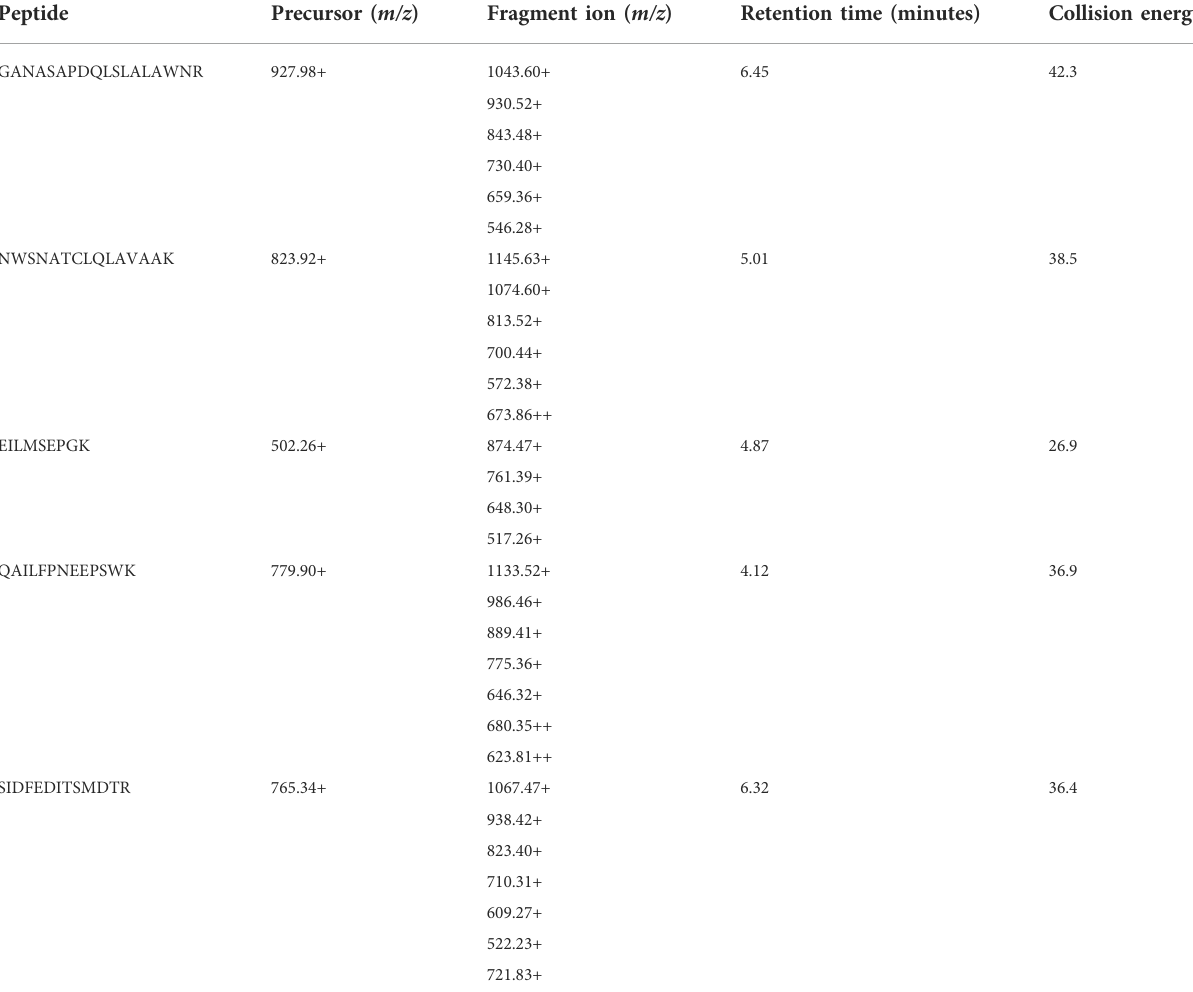
TABLE 2 Identi fi cation of high responding tryptic peptides.